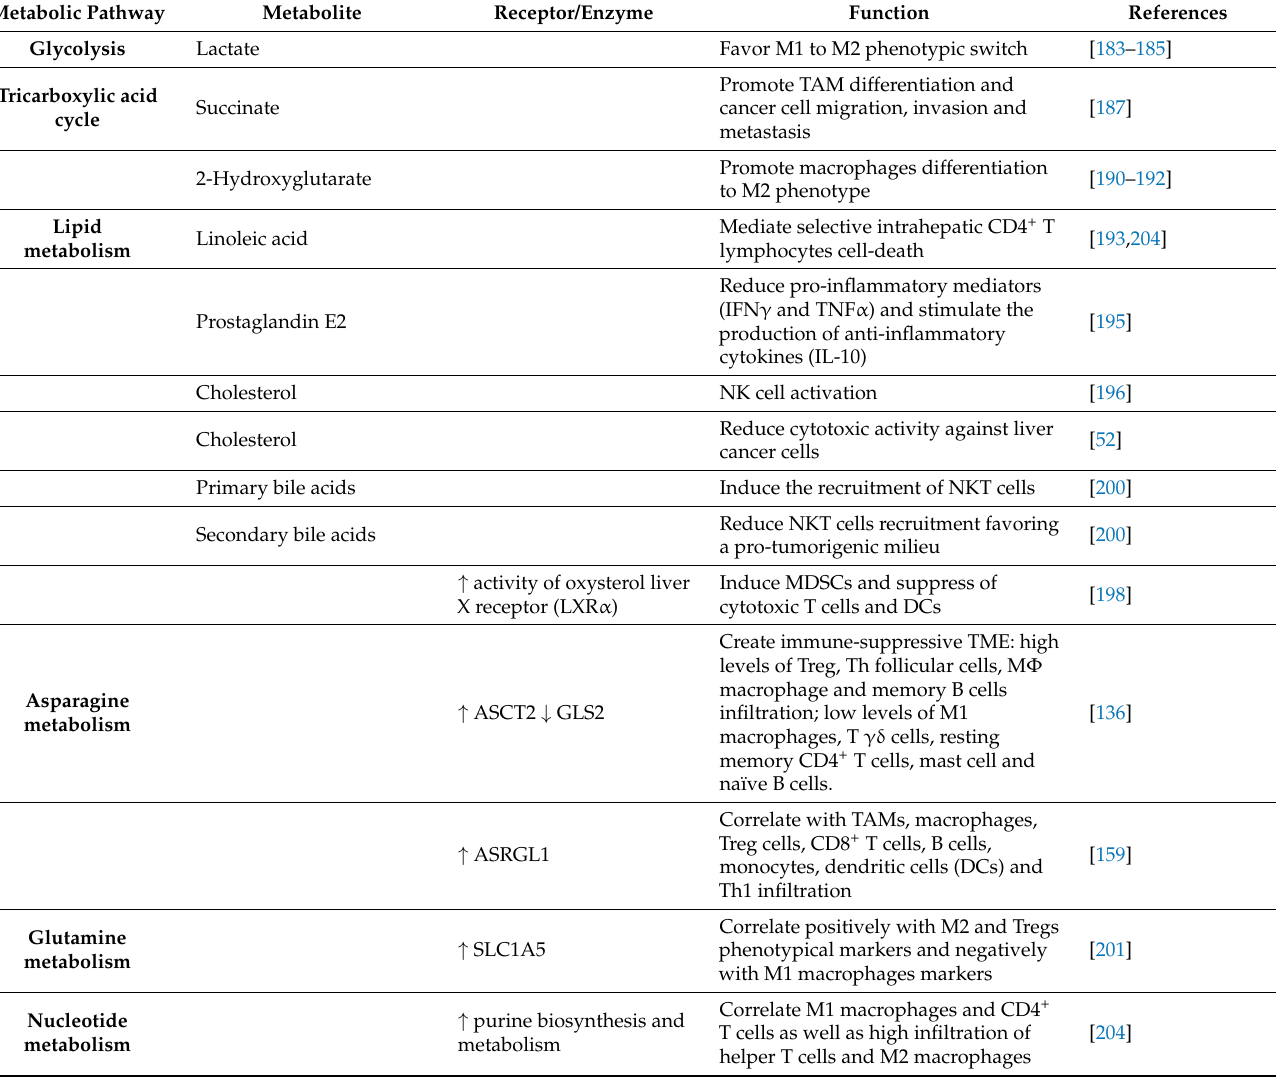
Table 1. Main relations between liver cancer cells rewiring and immune